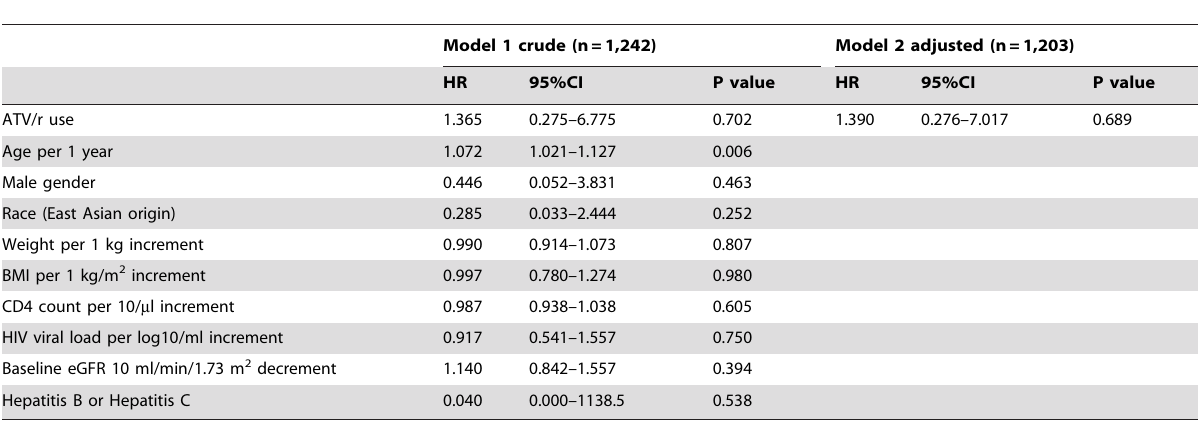
Table 2. Uni-and multi-variate analyses to estimate the risk of ATV/r use over other PIs-containing antiretroviral therapies for